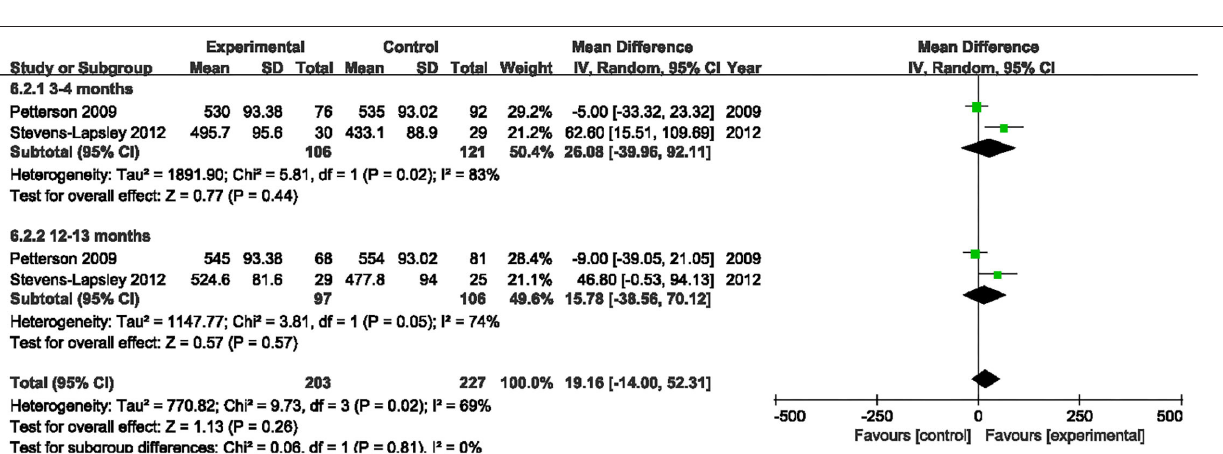
Frontiers in Medicine |